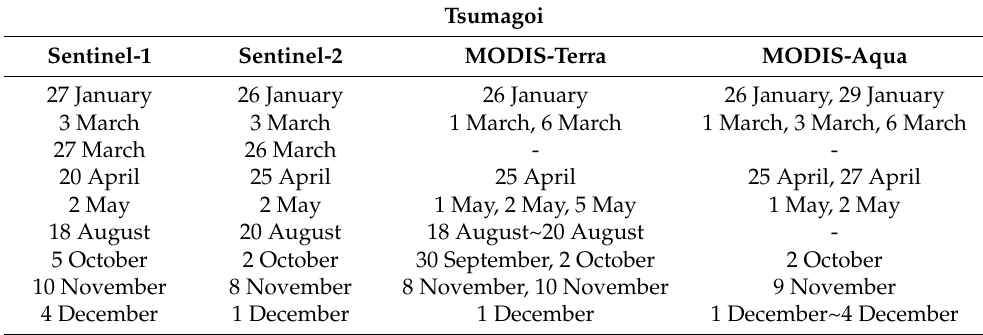
Table 3. Date of acquired data. Hyphens (-) express no cloudless data available.